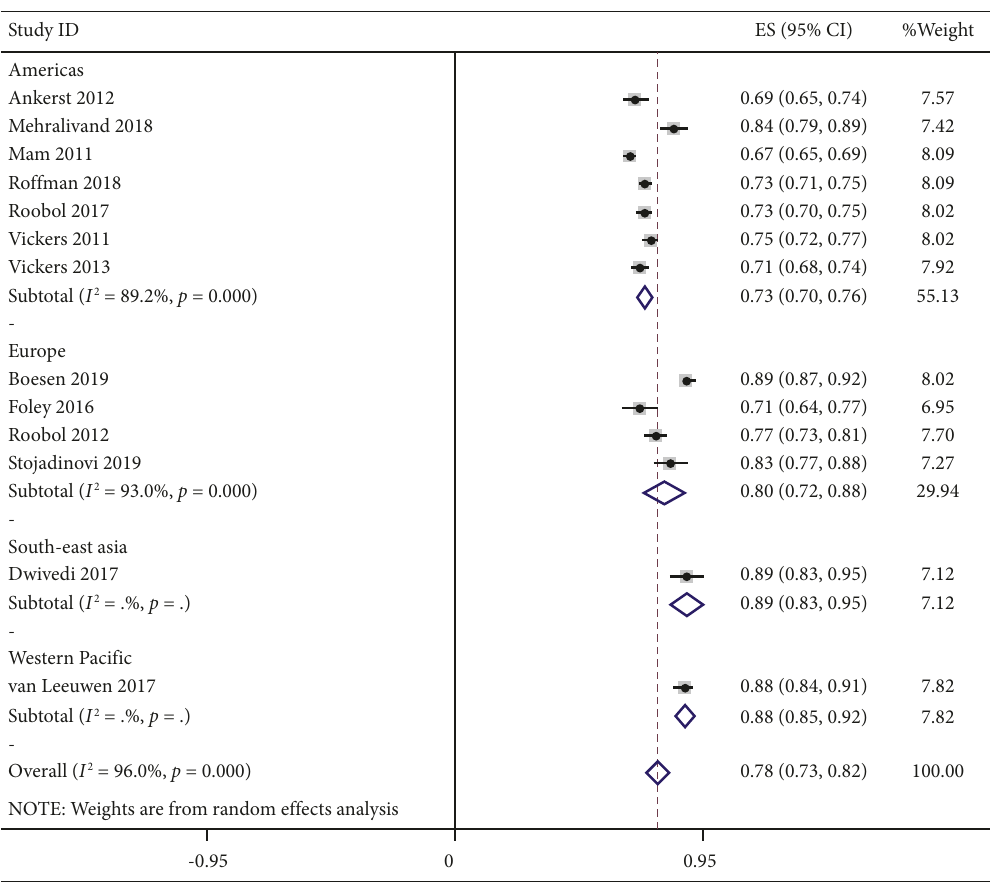
Figure 2: Forest plot of AUC (95% CI) of predictive models in the different regions.